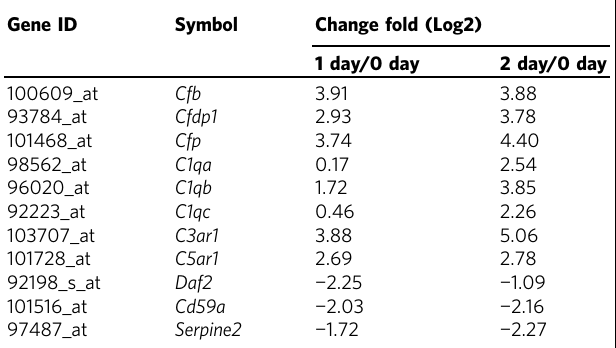
Table 1 The expression level of complement system genes